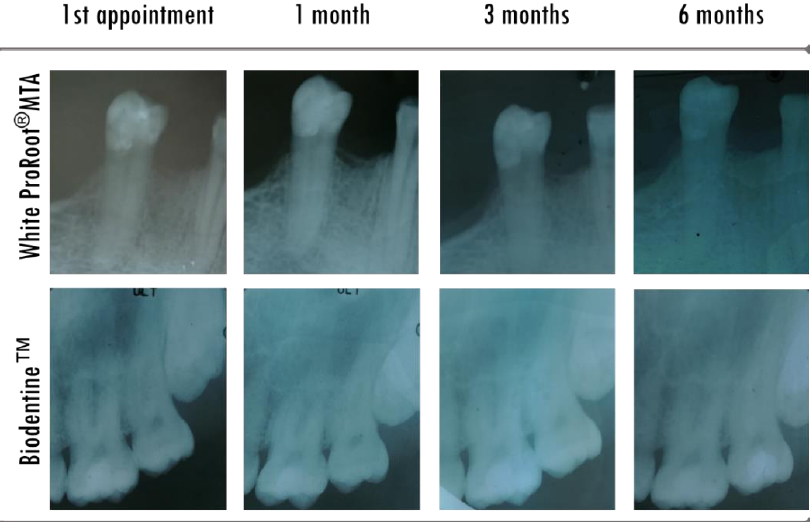
Figure 5. Radiographic images corresponding to direct pulp capping therapies with WhiteProRoot ® MTA and Biodentine ™ biomaterials. Therapy with WhiteProRoot ® MTA was performed on tooth 35, with iatrogenic pulp exposure <2 mm, with haemorrhage and under absolute isolation. The definitive restoration was performed after therapy at the same appointment with a total-etch adhesive Scotchbond 1 ® (3M/ESPE, Burgdorf, Schweiz) and composite resin Synergy D6 ® (Coltène/Whaledent AG, Altstätten, Switzerland). Biodentine ™ therapy was performed on tooth 26, with pulpal exposure due to carious lesion between 1 and 2 mm, without bleeding and under absolute isolation, and was definitively restored after therapy with a total-etch adhesive Scotchbond 1 ® and resin composite Synergy D6 ® .